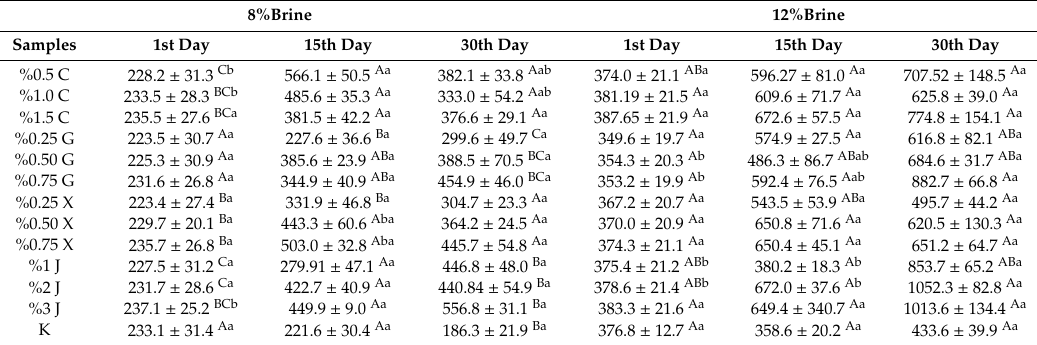
Table 6. Hardness (g) of cheese samples during storage. 8%Brine